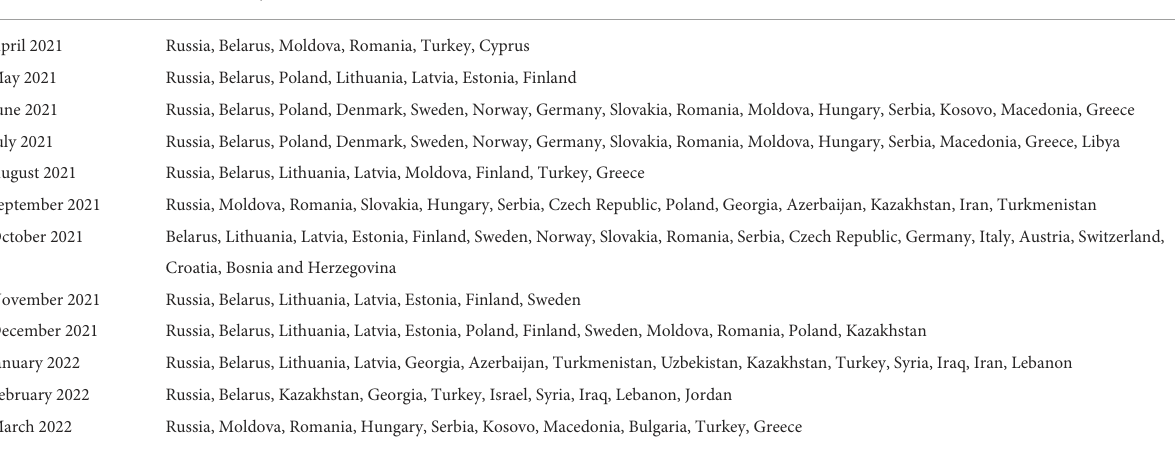
TABLE 2 List of countries which contaminated air mass will potentially travel over their air space from April 2021 to March